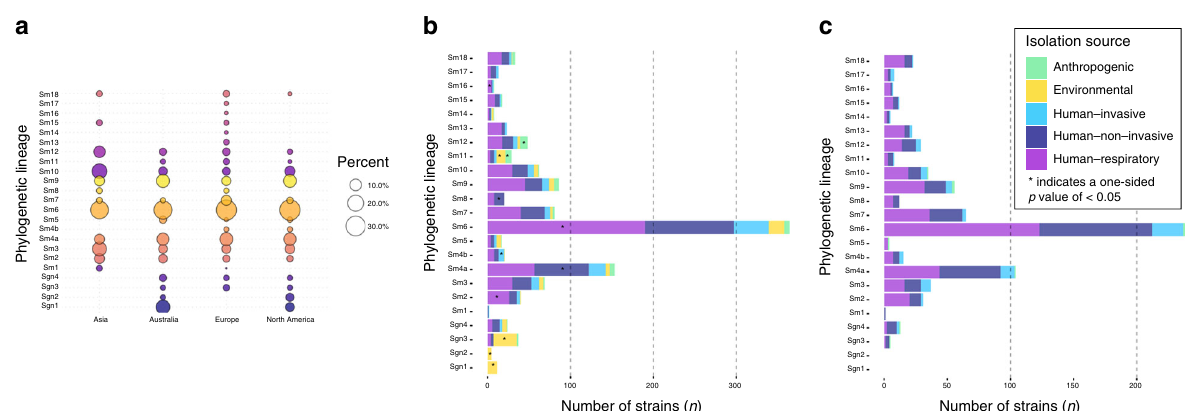
Fig. 2 Global distribution of lineages, their composition by isolation source and contribution to phylogenetic lineage total number of strains. a Bubble plot illustrating the proportion of lineages per continent. b Barplot showing the number of strains per lineage coloured by isolation source for the entire strain collection (see colour legend in c ). c Barplot for the prospectively sampled representative collection of human-associated S. maltophilia complex strains per lineage coloured by human-invasive, human-non-invasive or human-respiratory. One-sided p -values for all within-lineage comparison of isolation sources can be found in Supplementary Table 3. n = 1179 S. maltophilia isolates where isolation source was known. ‘ *' indicates a p -value of < 0.05 using one-sided Fisher ’ s exact test (for n < 5) or test of equal and given proportions corrected for multiple testing using the Benjamini – Hochberg